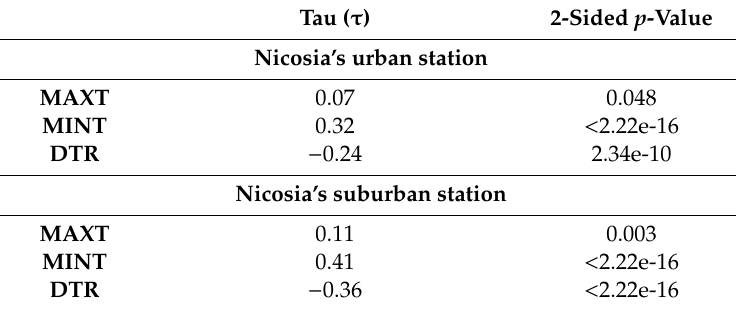
Table 2. Seasonal Mann–Kendall trends of daily maximum temperature (MAXT), minimum